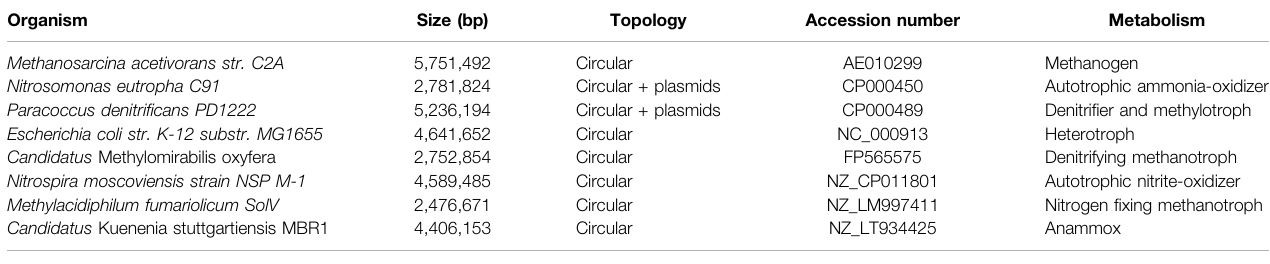
TABLE 1 | Genomes used in the mock community of this study. Organism